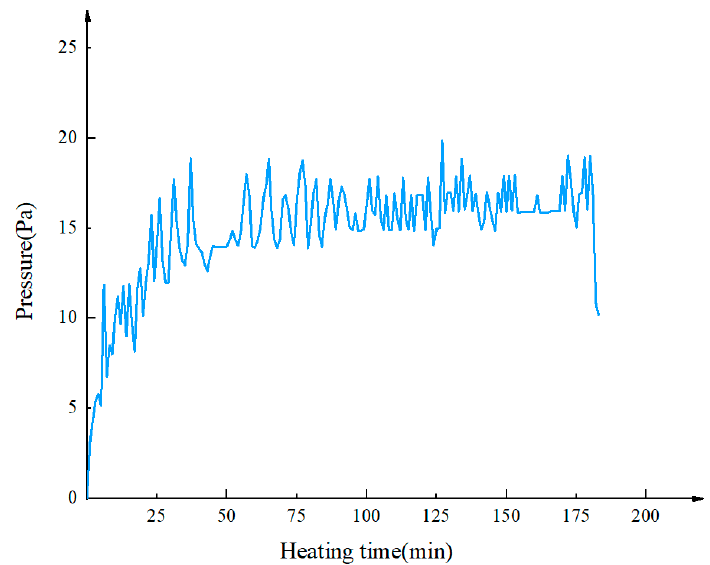
Figure 5. Temperature rise curve.